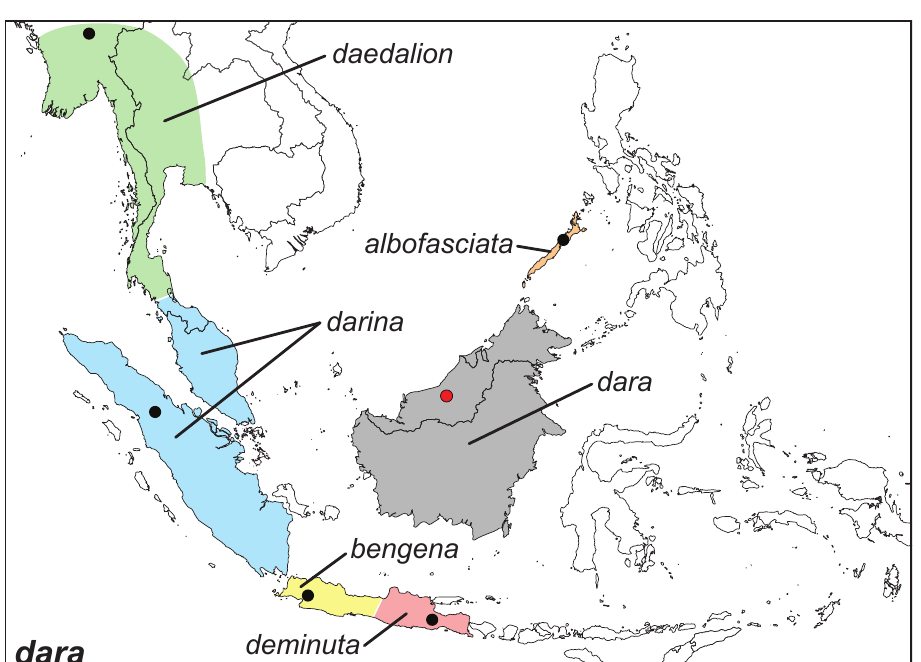
Figure 32. Distribution map of Elymnias dara